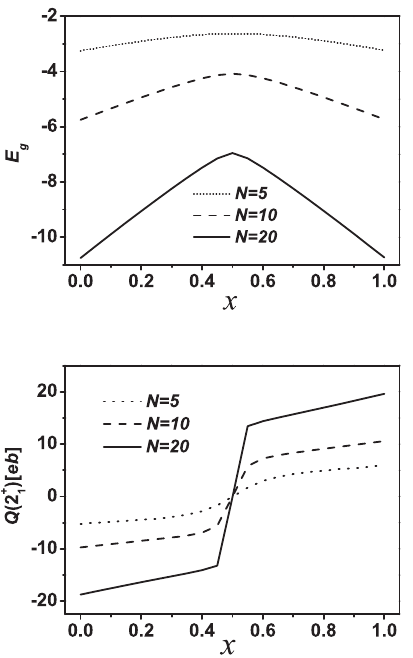
/ E 2 / E 2 , R 6 / 2 = E 6 and 1 1 1 1